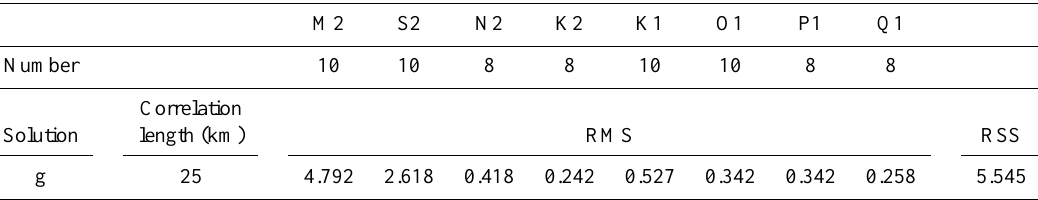
Table 8. RMS and RSS of the differences between the constituents of the control data set (ii) and the solution (g). Solution (g) does not assimilate any tide-gauge from the control set (ii). Sfax and Portsaid include 4 constituents. Unit iscm.